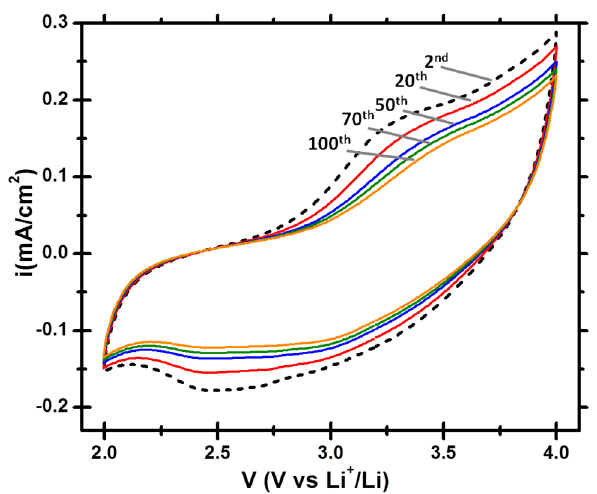
Figure 8. Cyclic voltammograms for Li ‐ ion insertion and extraction for 240 nm EMD anodically deposited on C/TiN/Si pillars obtained in 1 M LiClO 4 in propylene carbonate at a scan rate of 10 mVs − 1 —Cycles 2, 20, 50,70 and 100 are shown for a total of 100 consecutive cycles. The EMD films were deposited at 4.5 mA/cm 2 s at 40 °C. After the deposition, the annealing step is made at 350 °C for three hours in N 2 atmosphere to enable the lithiation.